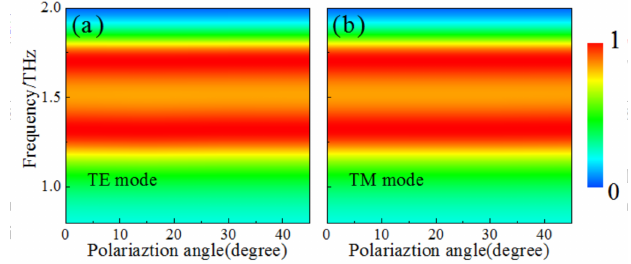
Figure 5. The absorption spectra under different polarization angles for ( a ) TE and ( b ) TM